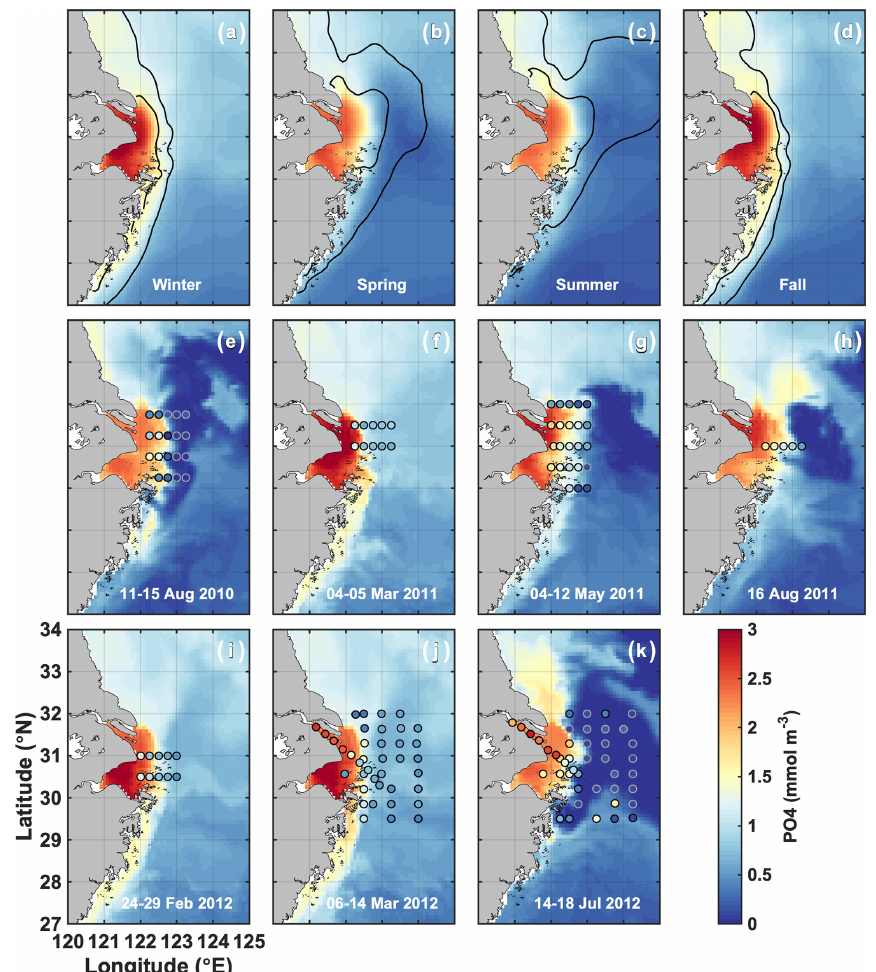
Figure 3. (a–d) Simulated seasonal means of surface PO 4 (2008–2013). The black contours indicate the 25 and 30 isohalines. (e–k) Com- parison of simulated surface PO 4 (colored maps) with the observations of Gao et al. (2015) for the dates indicated in each panel (colored dots). Simulated PO 4 corresponds to the average conditions during the